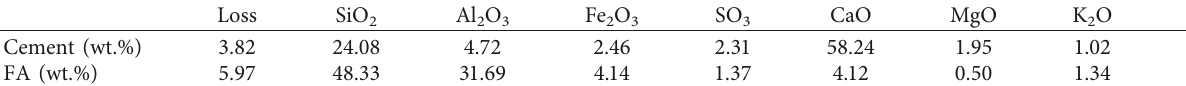
Table 1: Chemical compositions of cement and FA.